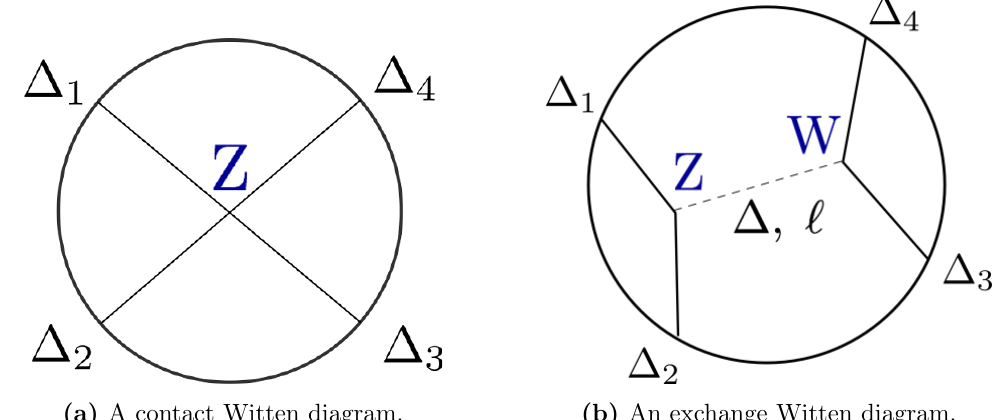
Figure 1. Connected four-point Witten diagrams at tree